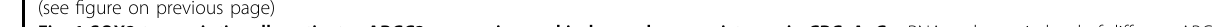
Fig. 1 SOX2 transcriptionally activates ABCC2 expression and induces chemoresistance in CRC. A – C mRNA and protein level of different ABC transporters were examined in SW480 and SW620 cells ( A ), SW480 cells transfected with SOX2 clone ( B ) as well as in SW620 cells transfected with SOX2 shRNA ( C ). D Chemoresistance was analyzed by drug sensitivity assay with SN38 in ABCC2-overexpressing SW480 cells and ABCC2-silencing SW620 cells. E ABCC2 overexpression or knockdown was conducted in SW480 and SW620 cells transfected with SOX2 clone or SOX2 shRNA, then chemoresistance was analyzed by drug sensitivity assay with SN38. F Schematic map of potential SOX2-binding site in the promoter of ABCC2 was shown according to the JASPAR database. G ChIP assay was used to con fi rm the interaction between SOX2 and ABCC2 promoter in SW480 and SW620 cells transfected with SOX2 clone or SOX2 shRNA. IgG antibody was used as a negative control, RNA polymerase II antibody was used as a positive control. H ABCC2 promoter-driven luciferase activity was assessed in HEK293T, SW480, and SW620 cells transfected with SOX2 clone or SOX2 shRNA. I , J Luciferase activity of ABCC2 promoter was examined in HEK293T cells transfected with truncated ABCC2 promoter ( I ) or deletion mutant of ABCC2 promoter ( J ). Experiments were conducted in triplicate. Data are shown as mean ± SEM. * P < 0.05, ** P < 0.01, and *** P <